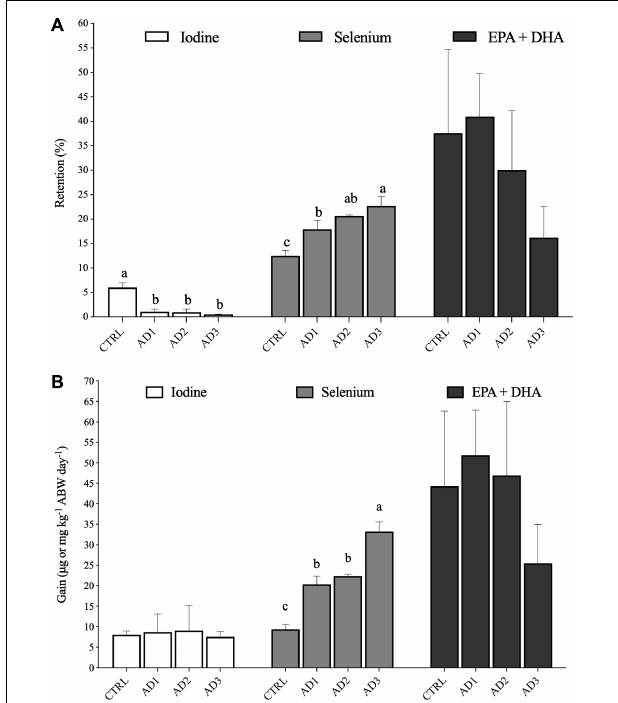
FIGURE 1 | (A) Retention (% feed intake) and (B) Gain of iodine and selenium ( µ g kg − 1 ABW day − 1 ) and of EPA + DHA (mg kg − 1 ABW day − 1 ). EPA + DHA = eicosapentaenoic acid + docosahexaenoic acid. Values are presented as mean ± SD. Different letters denote significant differences among